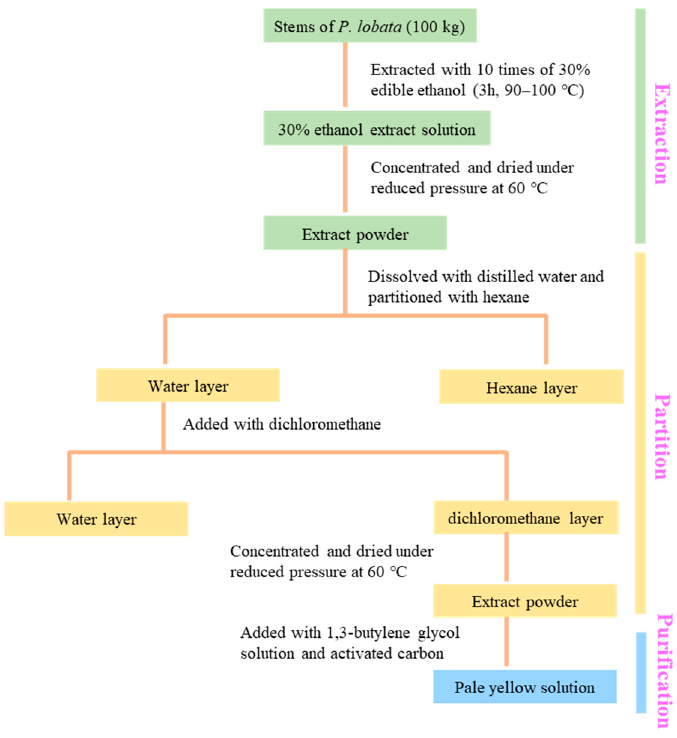
Figure 5. Extraction, partition and purification of fractions from stems of P. lobata .